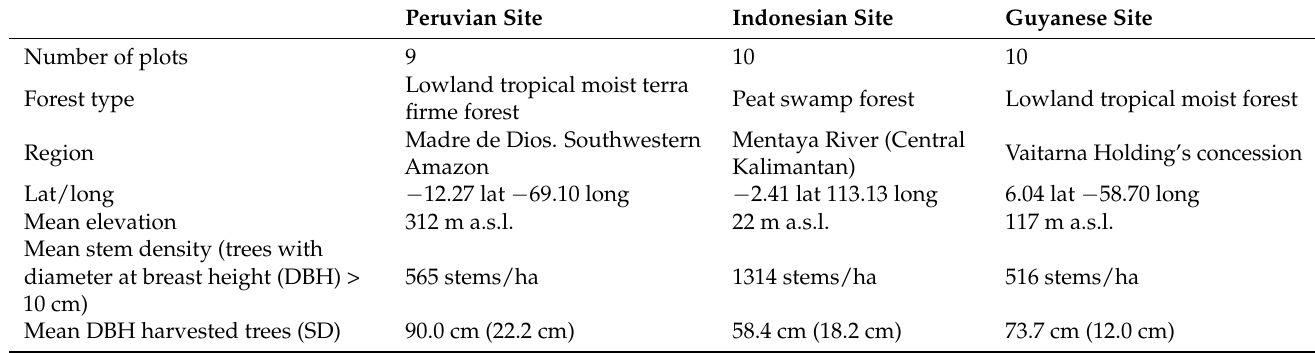
Table 3. Study site descriptions